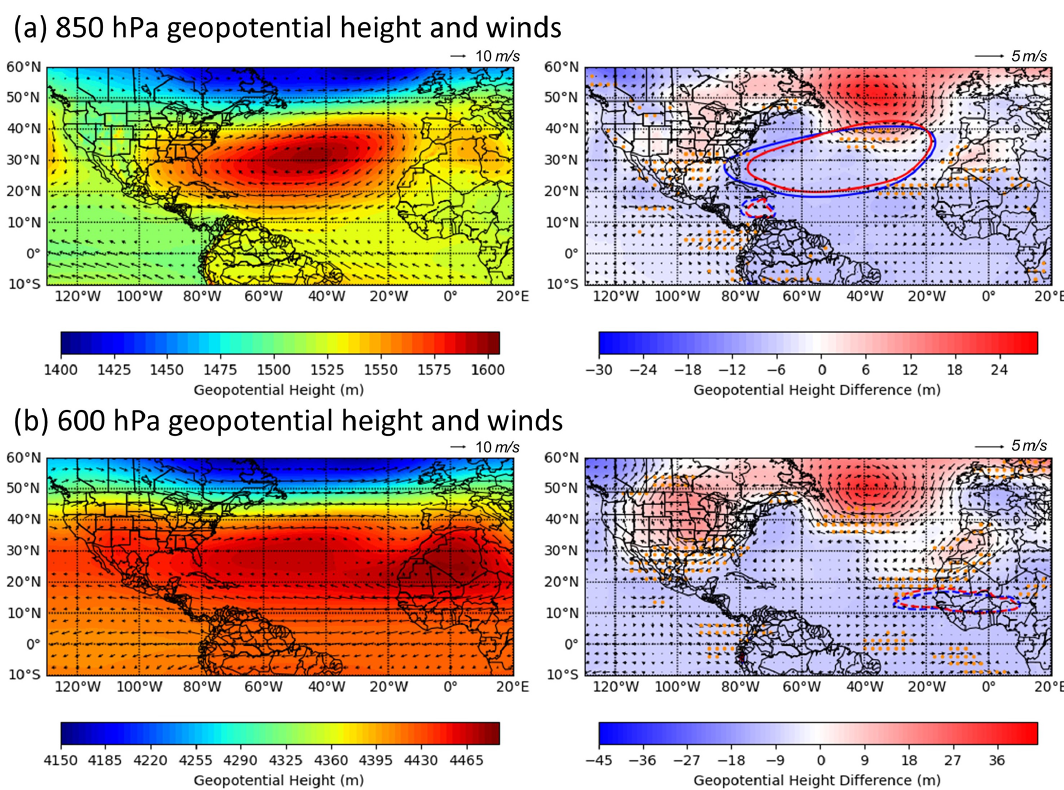
Figure 6. Maps of geopotential height (shading) and wind vectors (arrows) at 850hPa (a) and 600hPa (b) under the USDM-based SEUS regional non-drought (wet and normal) conditions (left column) and their changes during severe-drought periods (right column) from 2000 to 2019 in JJA. Solid lines in (a) indicate the edge of the Bermuda High under non-drought (blue) and severe droughts (red). Dashed lines show the edge of Caribbean low-level jet (a) and African easterly jet (b) under non-drought (blue) and severe droughts (red). Orange dots (right column) indicate the grids with significant differences in zonal winds at a 95% confidence